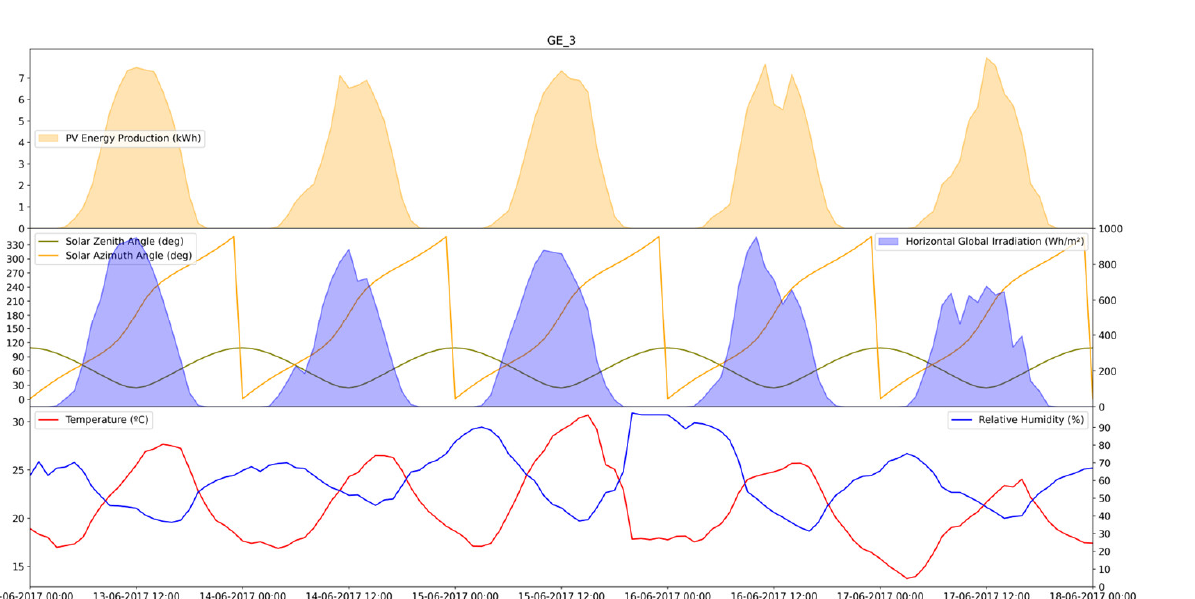
Table 1. Main characteristics of the PV facilities and datasets.